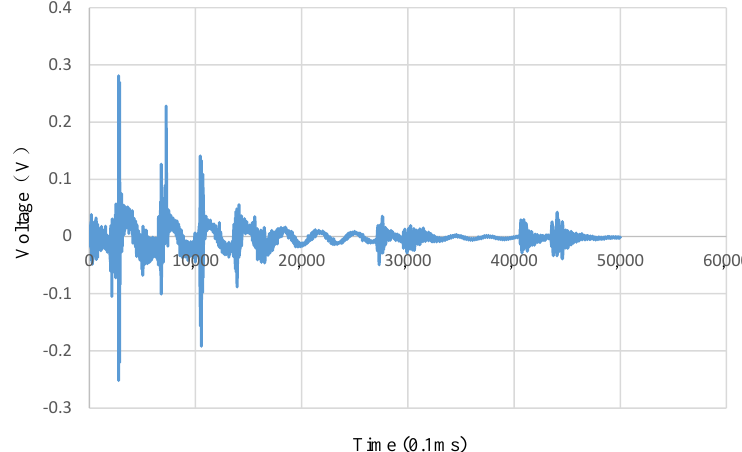
Figure 11. Signal voltage of bionic leg detected by the acceleration sensor.